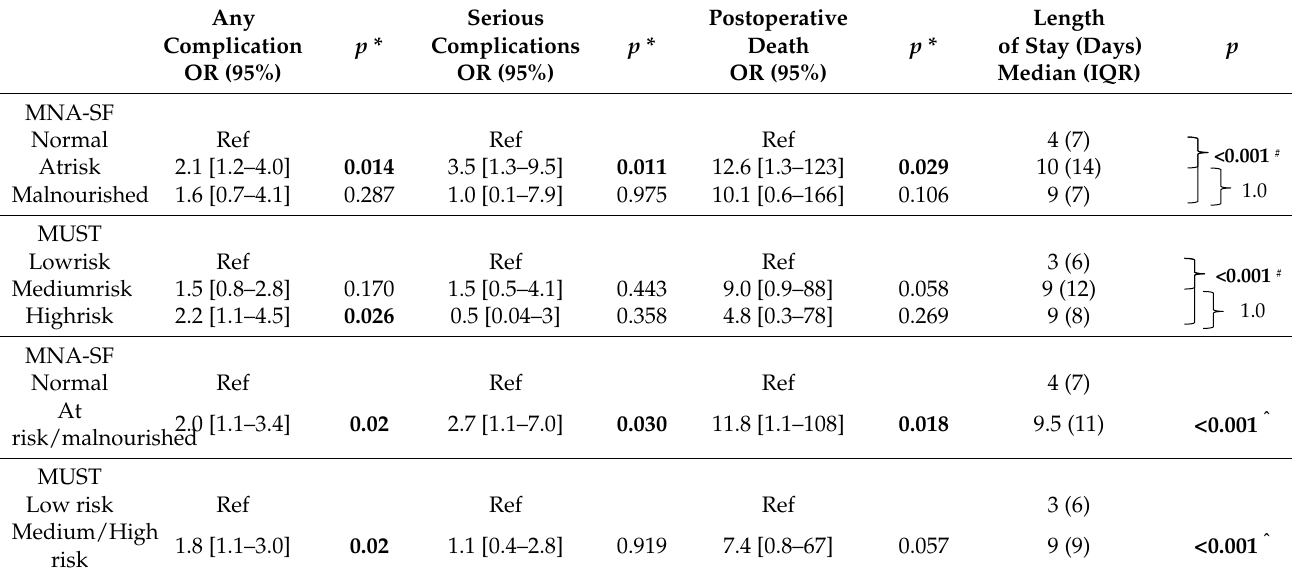
Table 2. Univariate analysis of the association of MNA-SF and MUST tool with postoperative outcomes in 302 elderly patients undergoing operations of general surgery.